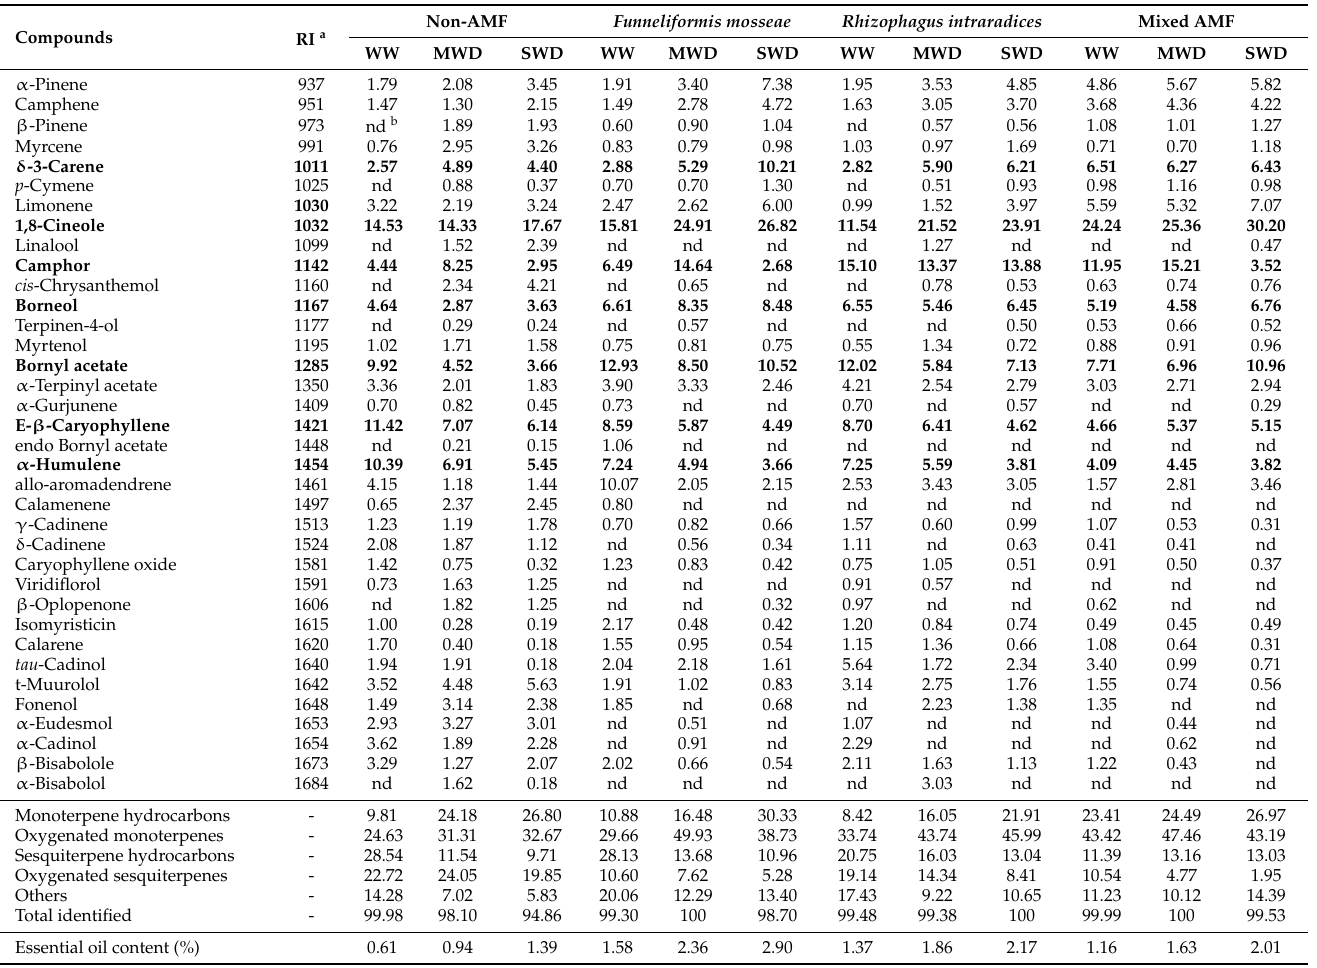
Table 5. The effects of AMF inoculation on essential oil chemical compositions and relative content (%) in S. yangii under different irrigation